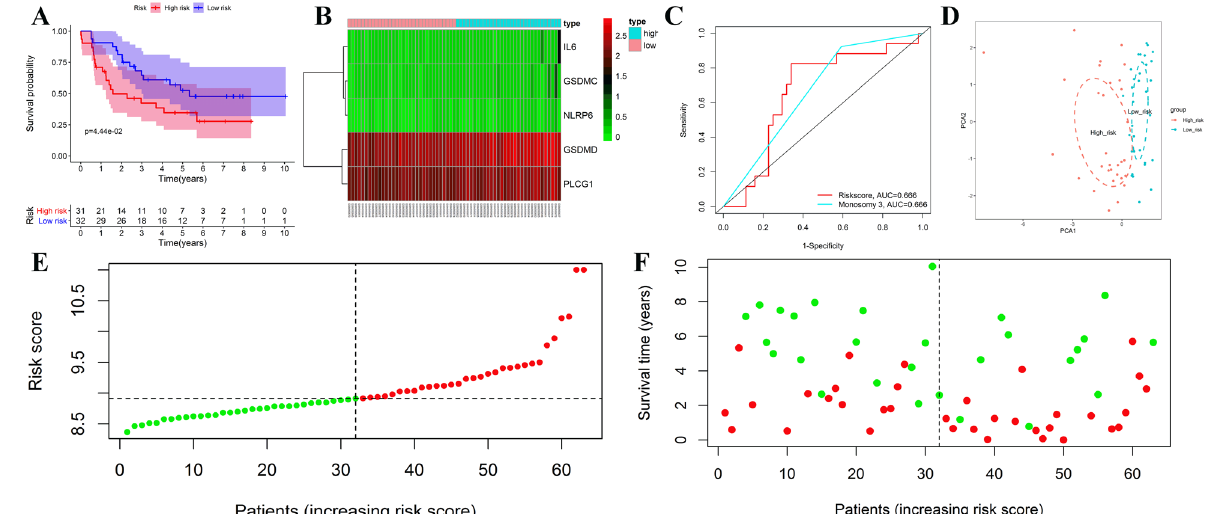
Figure 3. External validation of the risk signature in the validation cohort. KM curve for comparison of metastasis-free survival between low- and high-risk groups ( A ). Heatmap of differentially expressed pyroptosis- related genes ( B ). Time-dependent ROC curves of the risk score and monosomy 3 ( C ). PCA plot based on the risk score; The red dots represent high-risk patients, whereas the blue dots represent low-risk patients ( D ). Distribution of risk scores between low- and high-risk groups; The red dots represent high-risk patients, whereas the green dots represent low-risk patients ( E ). Survival status of UM patients in the low- and high-risk groups; The red dots represent deaths, whereas the green dots represent survivals ( F ). The figure was performed using R software (version 3.3.1, Vienna, Austria, https:// www.r- proje ct.